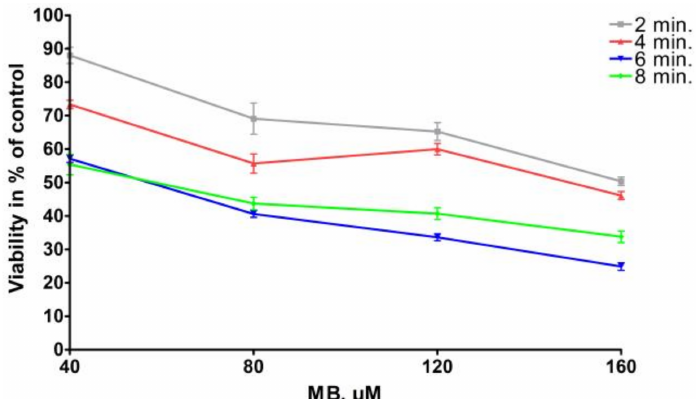
Figure 2. Time and concentration dependent toxic effects of MB on Detroit 562 cells, in percentage of viable cells. MB exposure at concentration of 160 µ M for 6–8 min caused up to 75% loss of cells compared to control (sham, scattered light in neighboring wells).